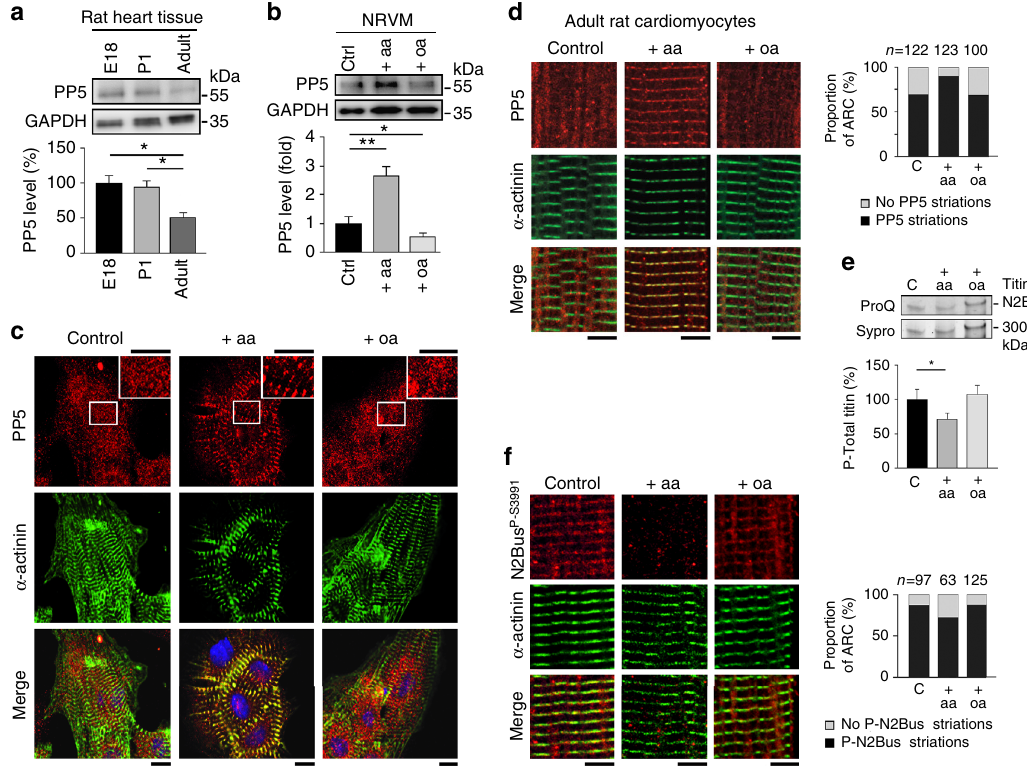
Fig. 2 Endogenous PP5 and phospho-titin in rat cardiomyocytes. a PP5 expression by western blot in fetal (E18), newborn (P1) and adult rat heart tissue. PP5 indexed to GAPDH. Data are mean ± s.e.m., n = 5; * p < 0.05, by two-tailed Student ’ s t -test. b PP5 expression by western blot in neonatal rat ventricular myocyte (NRVM) cultures under baseline conditions (control) and following treatment with arachidonic acid (aa; 200 µ M, 2 h) or okadaic acid (oa, 10 nM, 1 h). PP5 indexed to GAPDH. Data are mean ± s.e.m., n = 5 (three different cell culture batches); * p < 0.05 and ** p < 0.01, by Bonferroni adjusted t -test. c PP5 localization in control, aa-treated, and oa-treated NRVM cultures by indirect immuno fl uorescence. PP5 antibody (secondary antibody: Cy3-conjugated IgG), counterstained with α -actinin antibody (secondary antibody: FITC-conjugated IgG). The merged image also shows staining of nuclei using Hoechst. Bars, 10 µ m. d PP5 localization in control, aa-treated, and oa-treated adult rat cardiomyocyte (ARC) cultures by indirect immuno fl uorescence. The same antibodies as in c were used. Bars, 5 µ m. Right bar graph shows proportion of ARC exhibiting clear PP5 striations or no such striated pattern, for each group. Numbers above columns indicate total number of cells included in the analysis. e Total titin phosphorylation in the three ARC groups measured by ProQ Diamond phosphoprotein vs. Sypro Ruby total protein stain. Bar graph shows mean ± s.e.m., n = 9 (from three independent cell preparations); * p < 0.05, by two-tailed Student ’ s t -test. f Localization of phosphoserine P-S3991 (titin N2Bus) in control, aa-treated, and oa-treated ARC cultures by indirect immuno fl uorescence, using anti-N2Bus P-S3991 antibody (secondary antibody: Cy3-conjugated IgG), counterstained with α -actinin antibody (secondary antibody: FITC-conjugated IgG). Bars, 5 µ m. Right bar graph shows proportion of ARC exhibiting clear N2Bus P-S3991 striations or no such striated pattern, for each group. Numbers above columns indicate total number of cells included in the